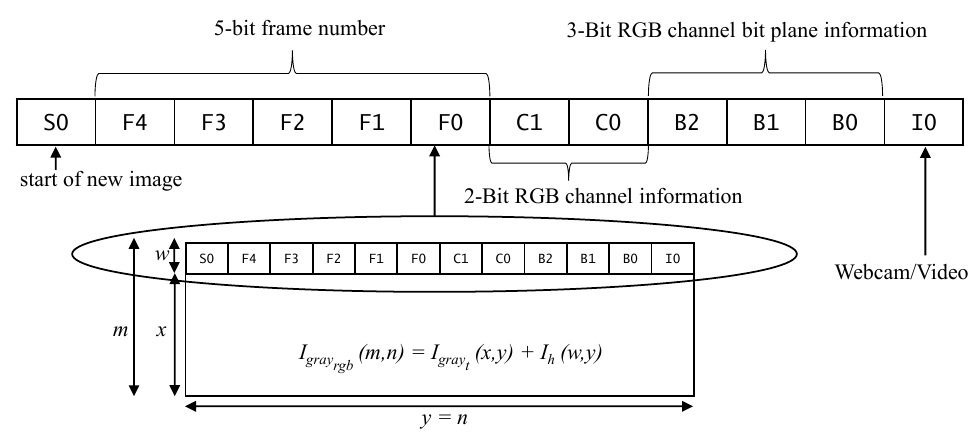
Figure 12. Header information.